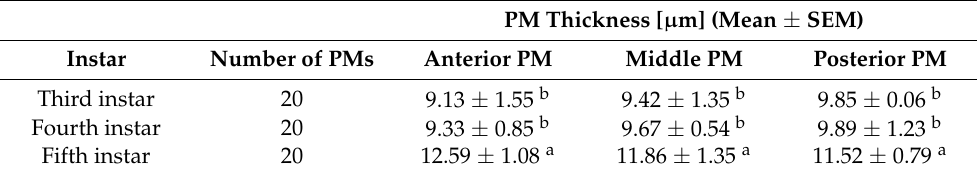
Table 2. Peritrophic matrix (PM) thickness at different developmental stages of the silkworm, Bombyx mori